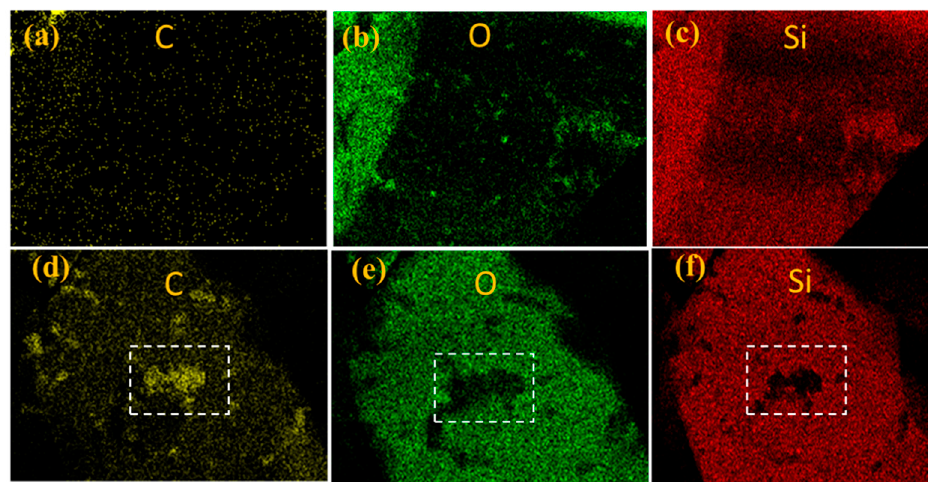
Figure 6. FSP ( a – c ) and FSP @ PUU-1 ( d – f ) corresponding to X-ray map of C, O and Si.